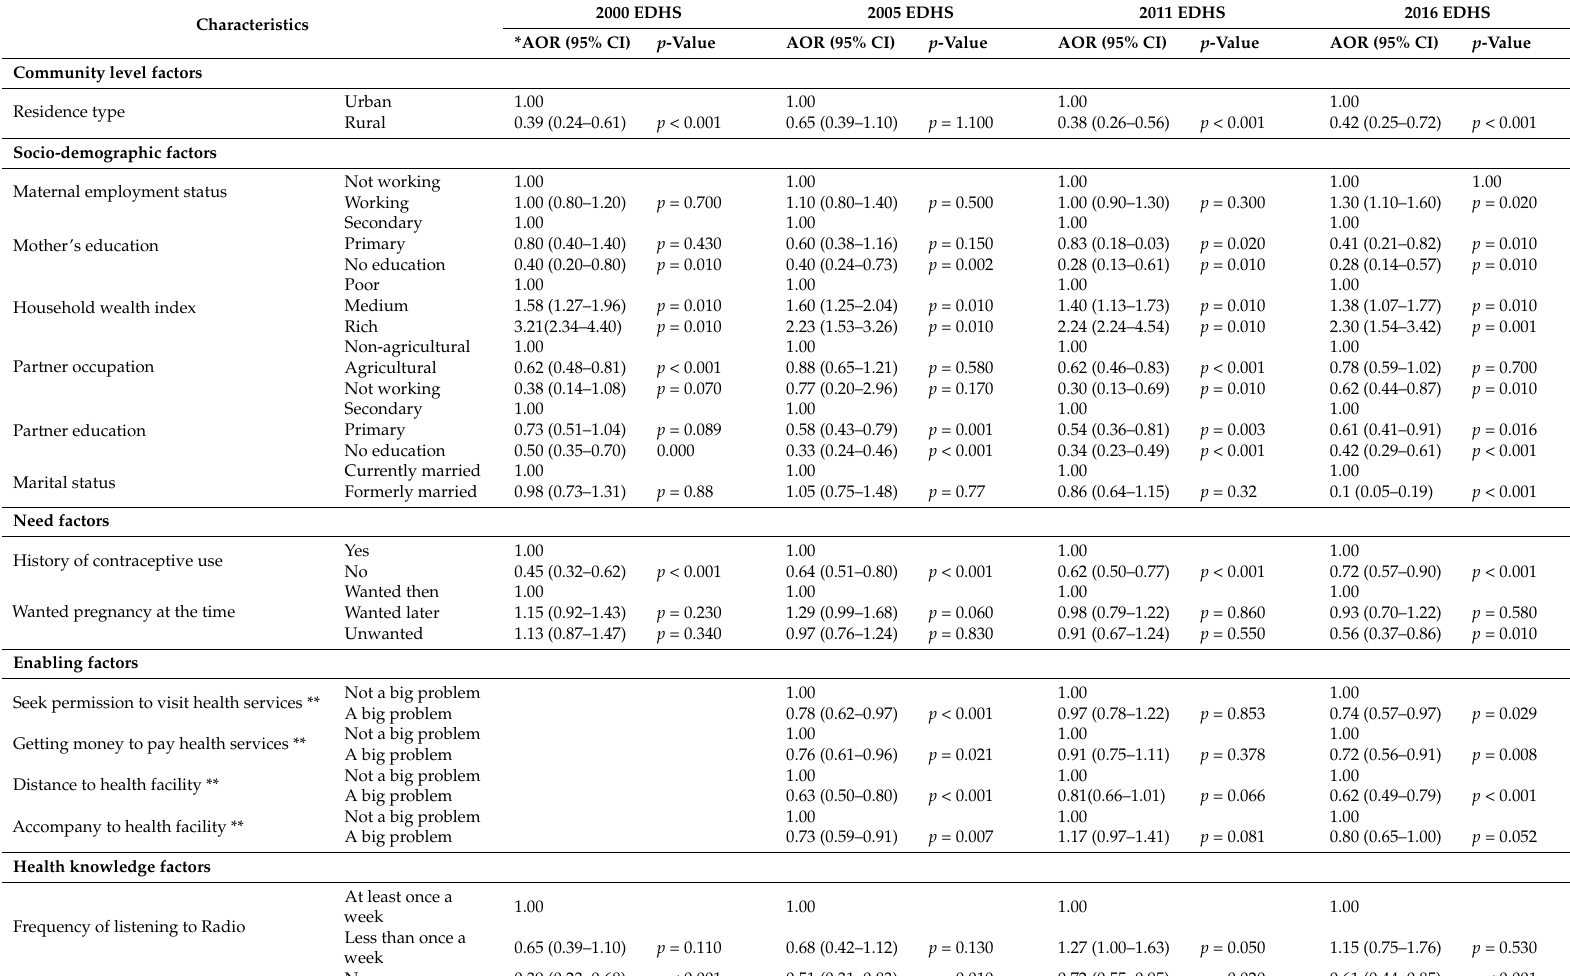
Table 3. Association between the study factors and ANC visits one to three in Ethiopia,